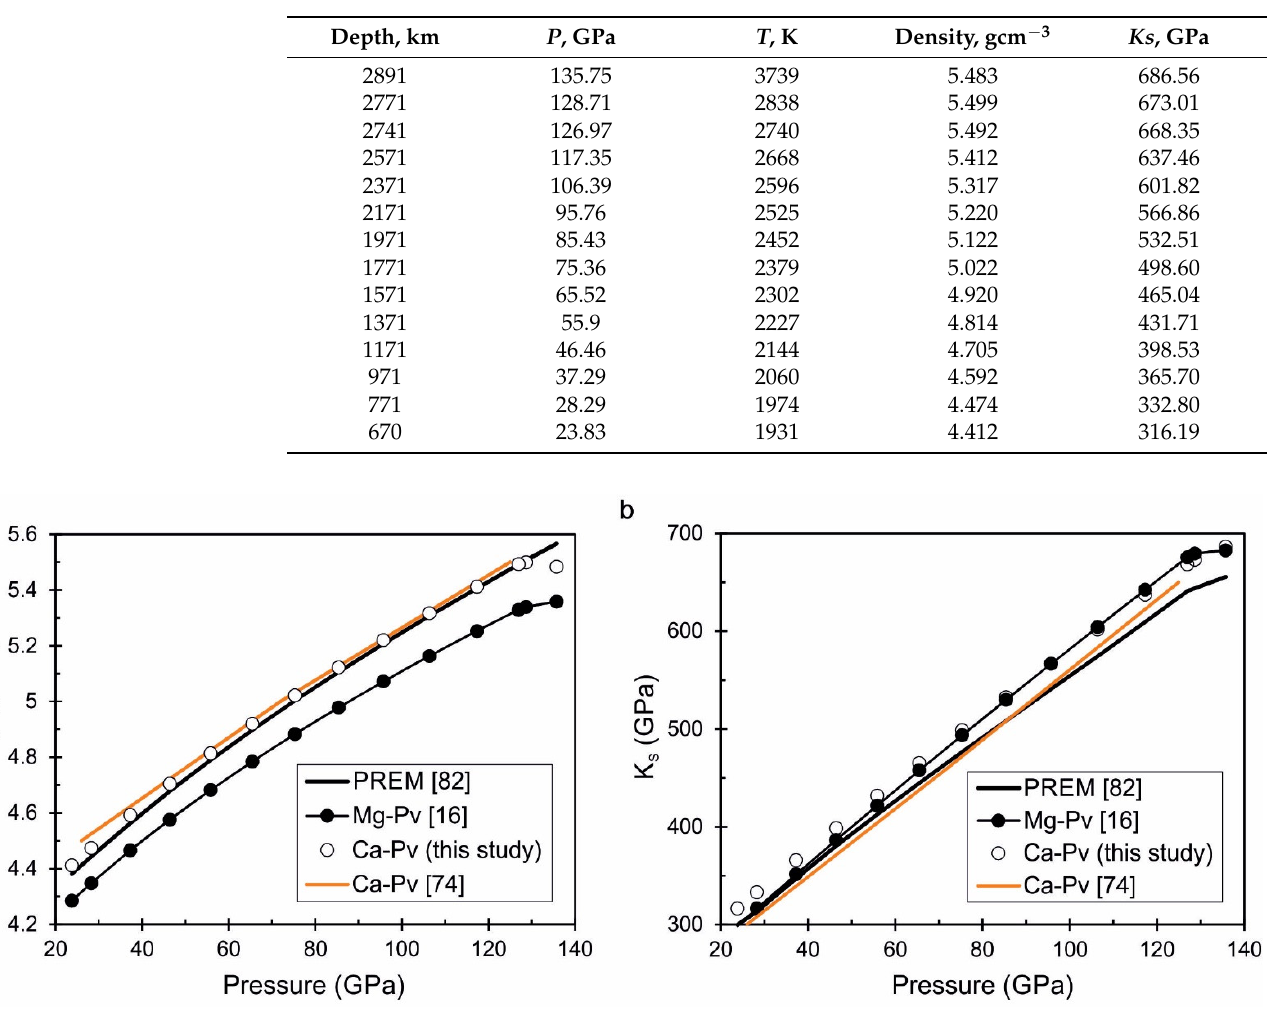
Table 4. Density and adiabatic bulk modulus of cubic CaSiO 3 -perovskite at temperature, pressure, and depth of the lower mantle from the Preliminary Reference Earth Model (PREM) model.